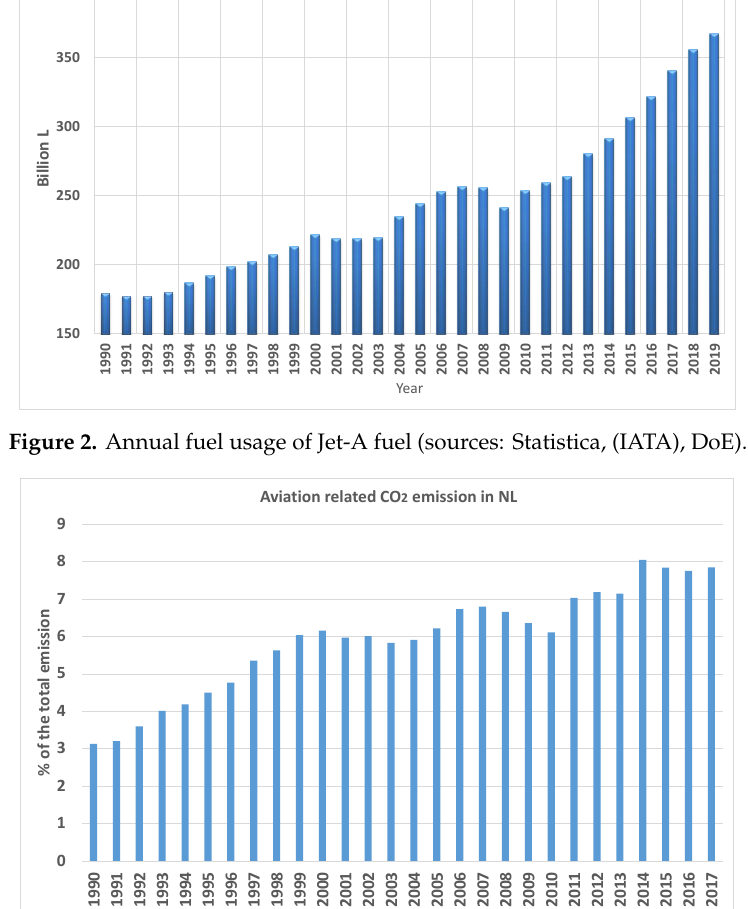
Figure 2. Annual fuel usage of Jet-A fuel (sources: Statistica, (IATA), DoE).